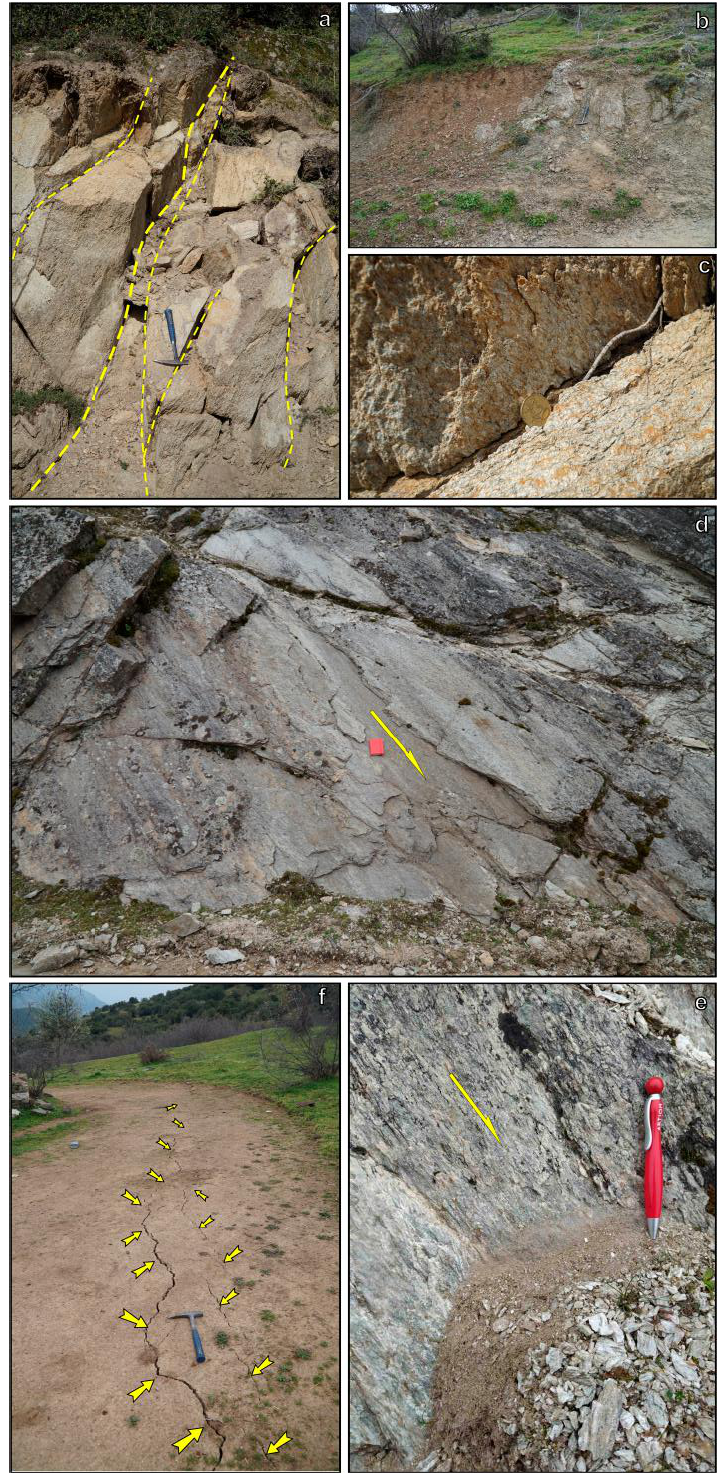
Figure 10. ( a ) Cataclasite and opening (yellow dashed lines with the thick one indicating the major opening) in Paleozoic crystalline rocks, ( b ) a zone of intense brittle shearing, accompanied by fault gouge and cataclasite within the Zarkos fault zone, ( c ) opening along a pre-existing shear zone, ( d , e ) fault surfaces of the Zarkos fault zone (yellow arrow shows the slip direction), ( f ) co-seismic surface fissures in the soil cover marked by the yellow arrows, following the inferred strike and location of the causative fault zone in the bedrock. Modified from Chatzipetros et al.